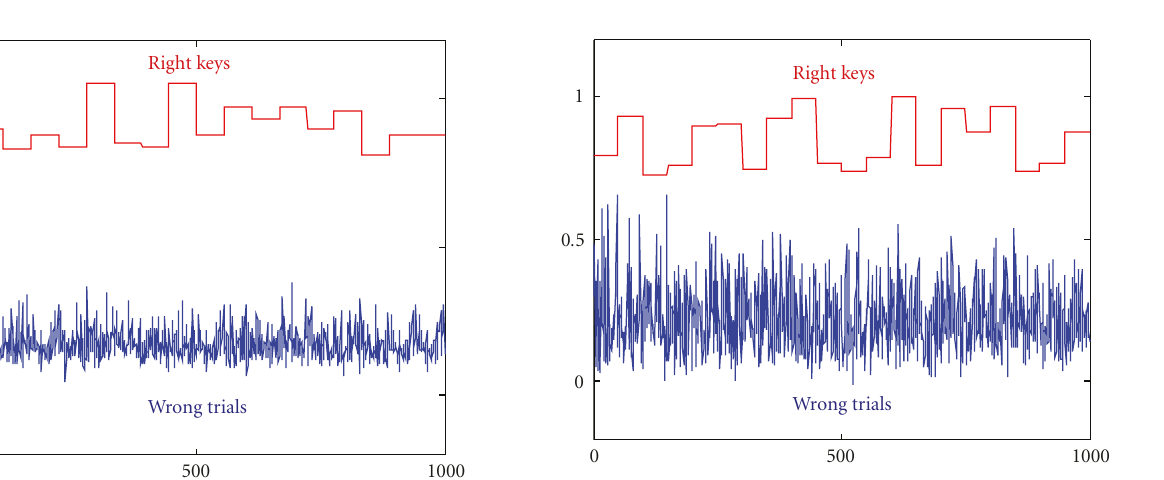
Figure 7: The normalized detector responses for a set of right keys and wrong trials (for the proposed approach).